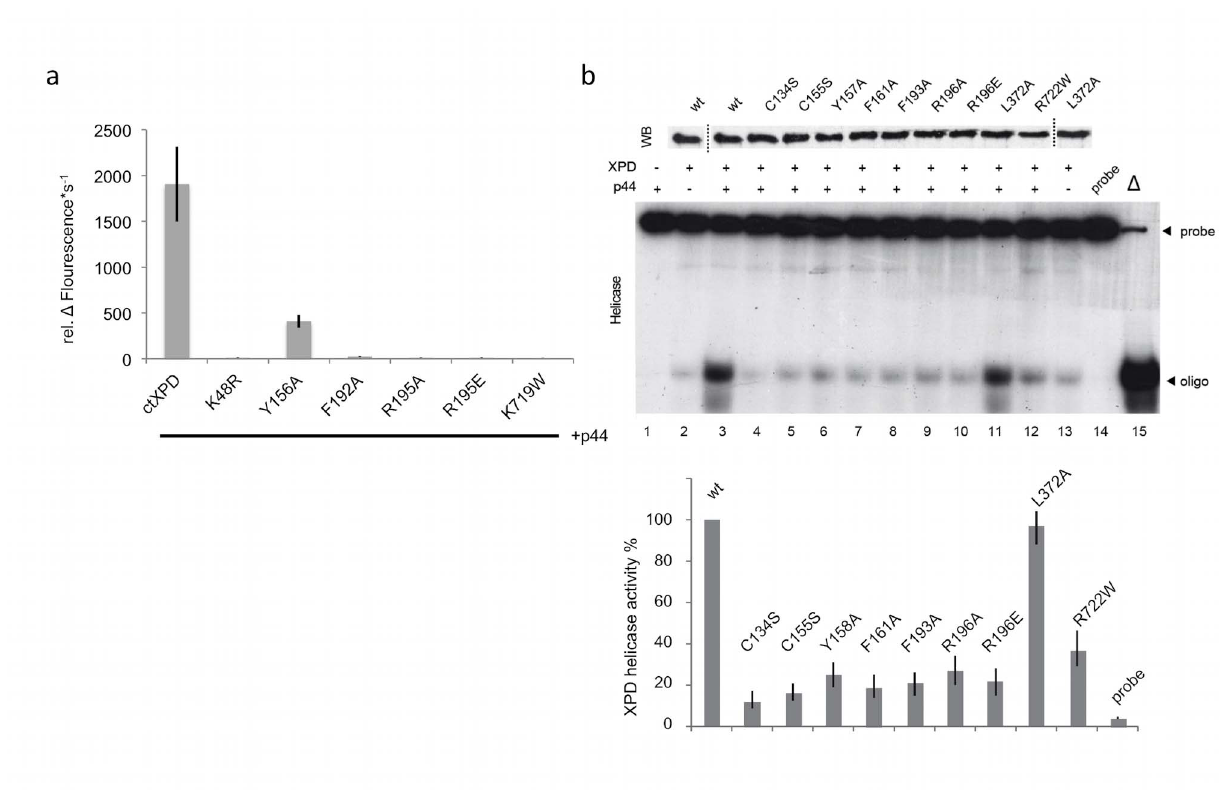
Figure 3. Helicase activity of ctXPD and hsXPD and its variants. (a) Helicase activity of wild-type ctXPD in the presence of ctp44 (1–285) and its variants analyzed utilizing a fluorescence-based helicase assay. (b) hsXPD wild-type and variants were expressed in insect cells using the baculovirus overexpression system and immunoprecipitated using an antibody (Ab) directed toward the Flag epitope fused at the N terminus of the protein. After elution with the Flag synthetic peptide, equal amounts of purified proteins were resolved by SDS/PAGE with 12% (w/v) polyacrylamide followed by Western blot (WB) analysis (upper panel, lanes 3 to 12). Bands shown in lanes 2 and 13 in the upper panel are a duplication of lanes 3 (wild type) and 11 (L372A). Purified XPD wild type and variants were added to a 5 9 -strand extension probe in the presence of an excess of p44 to evaluate their 5 9 –3 9 helicase activity. The reaction was analyzed by electrophoresis on a 14% (w/v) polyacrylamide gel and analyzed by autoradiography. Controls include reactions performed in the absence of wild-type XPD (lane 1) and in the absence of p44 (lane 2). The native and denatured probes have also been analyzed (lanes 14 and 15, lower panel). The data used to generate panels (a) and (b) have been deposited as supplementary information in xls format (Table